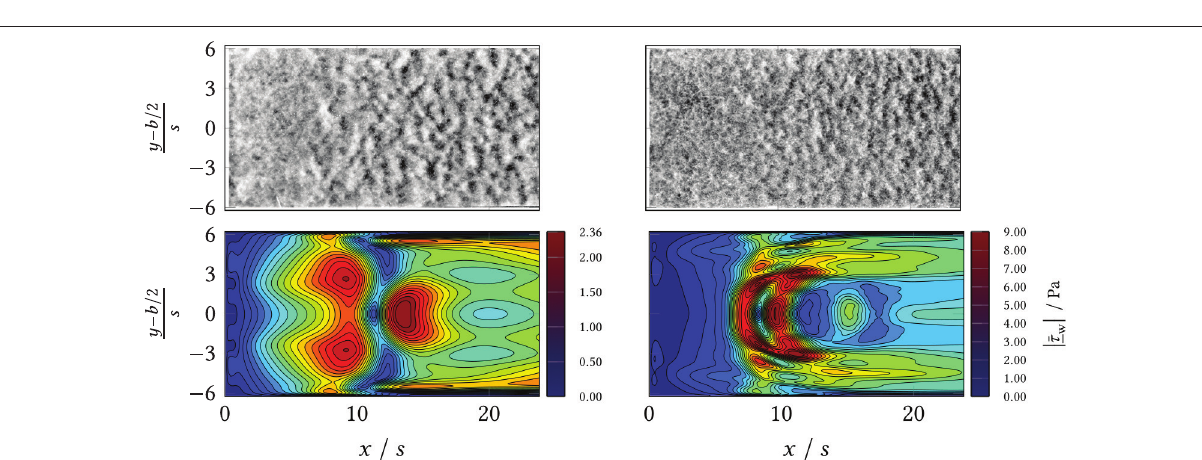
region and for t = 17 h in the back region, respectively. The